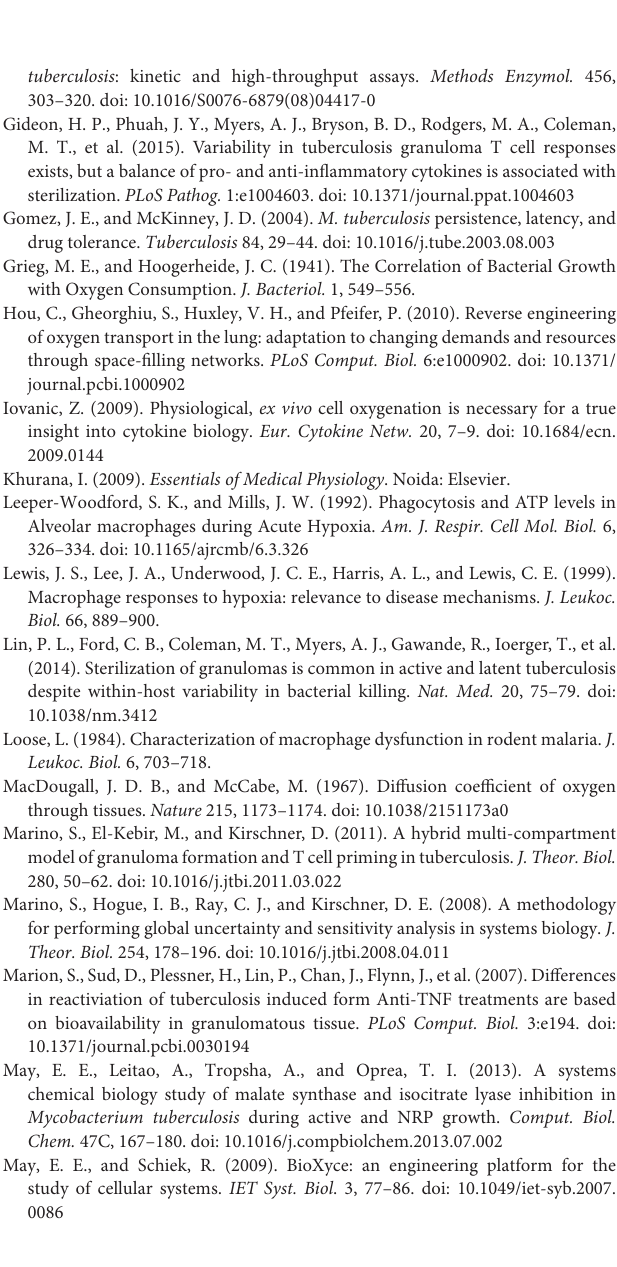
average growth rate of extracellular bacteria; (B) average growth rate of intracellular Bacteria; (C) average oxygen tension (mmHg); (D) average depletion rate. Averages over 300 total simulations. Supplementary Figure 6 | Significant Partial Rank Correlation Coefficients for the integrated multiscale model show the impact of oxygen dynamics and physiological host response on Mtb infection outcome. Extracellular Bacterial levels are used as the outcome measure. Analysis results are based on multi-sample averages of the 300 simulation outcomes (A) and 41 individual non-clearance outcomes (B) . Supplementary Figure 7 | Containment granuloma at 21 percent oxygen (left, A) and 18 percent oxygen (right, B). Supplementary Table 1 | Parameters of the containment and dissemination run both with the ABM as standalone model and the multi scale